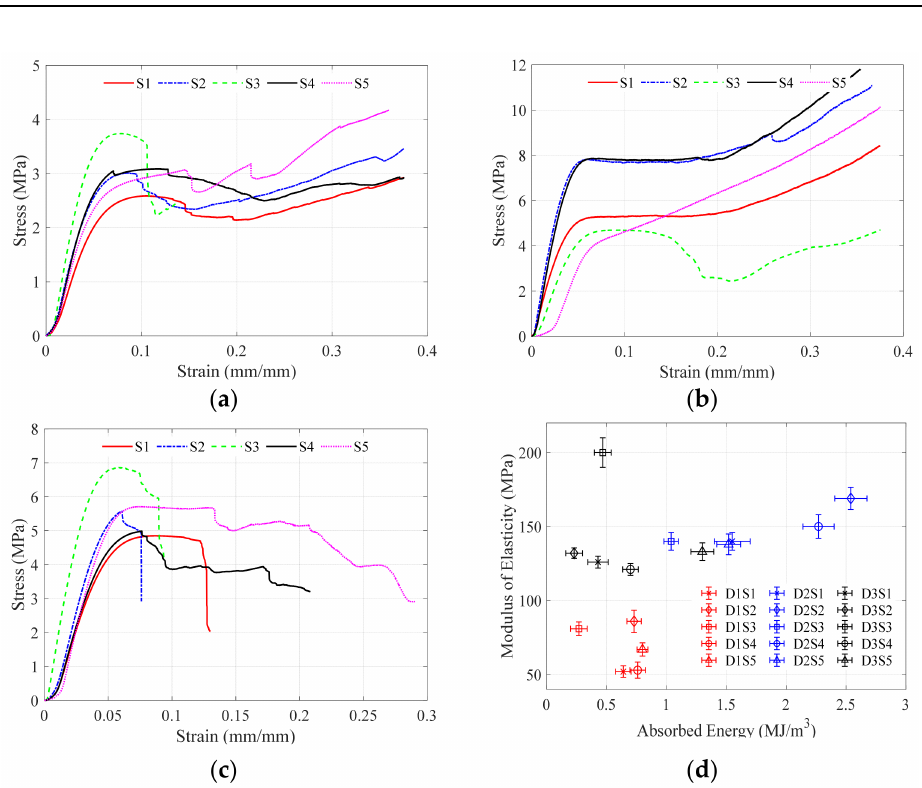
Figure 11. Stress-strain curves for ( a ) different cell size grading designs at D1, ( b ) different cell size grading designs at D2, ( c ) different cell size grading designs at D3, and ( d ) the modulus of elasticity and absorbed energy versus the 15 graded lattice